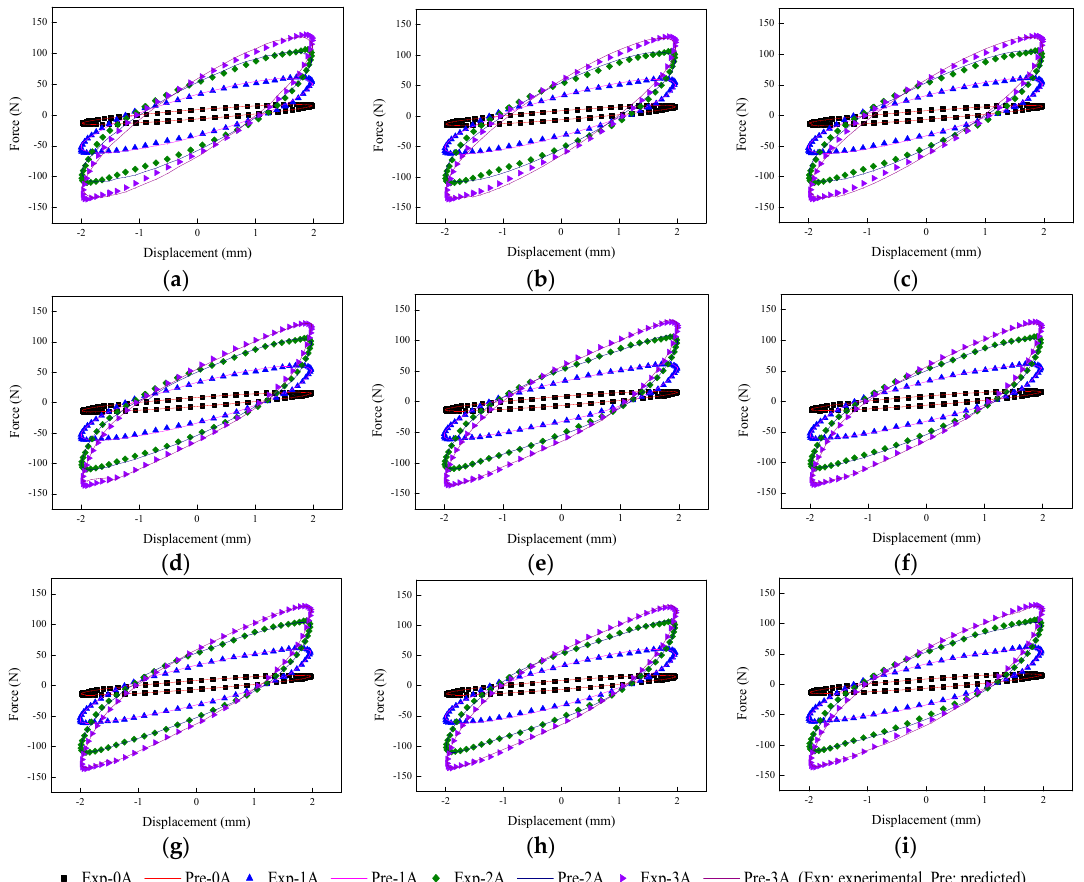
Figure 21. Comparisons of force–displacement responses between experimental results and model predictions when the loading amplitude is 2 mm. ( a ) Kelvin–Voigt model, ( b ) four-parameter viscoelastic model, ( c ) rheological model, ( d ) BW model, ( e ) improved BW model, ( f ) Dahl model, ( g ) improved LuGre friction model, ( h ) strain stiffening model, and ( i ) hyperbolic hysteresis model.